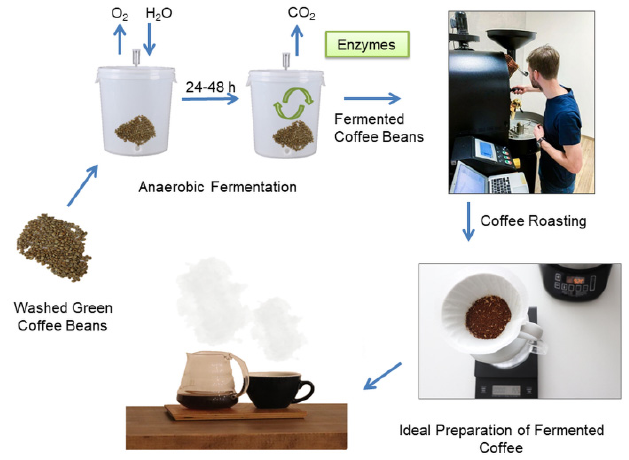
Figure 1. Life cycle of fermented coffee. Washed green coffee beans from the farm undergo anaerobic fermentation. The cherries were sealed for 24–48 h inside barrels filled with water with a one- way exit on the top. As the naturally incurring yeast interacts with the sugars of the coffee fruit,